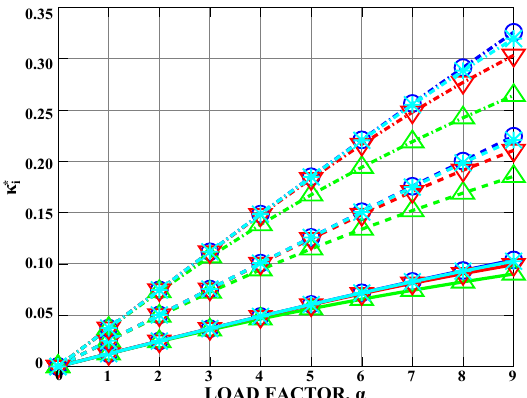
(solid line), ε ∗ Figure 11. Components of the stretch vector: ε ∗ 1 2 (dashed line), ε ∗ (dash-dotted line). Case 3a ( (cid:13) ), 3b ( 4 ), 3c ( 5 ), 3 3d ( ∗ ).